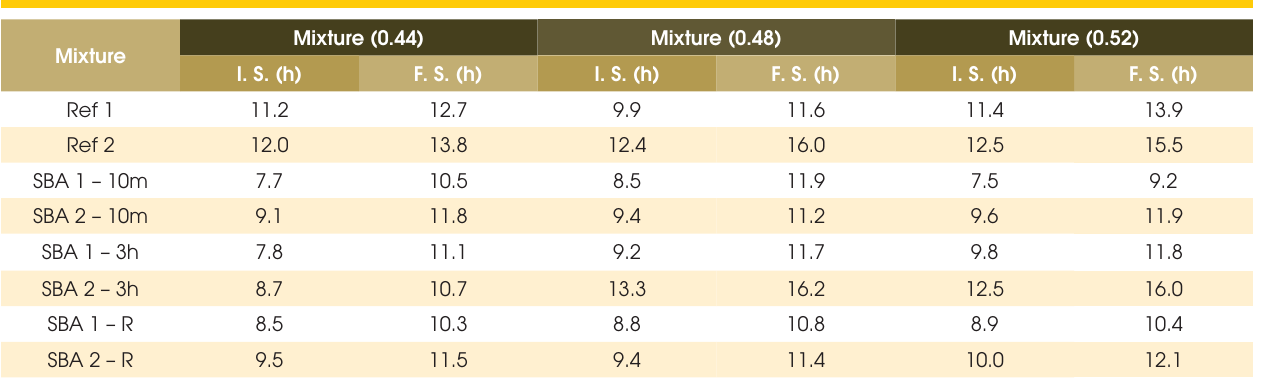
Table 7 – Initial setting time (I.S.) and final setting